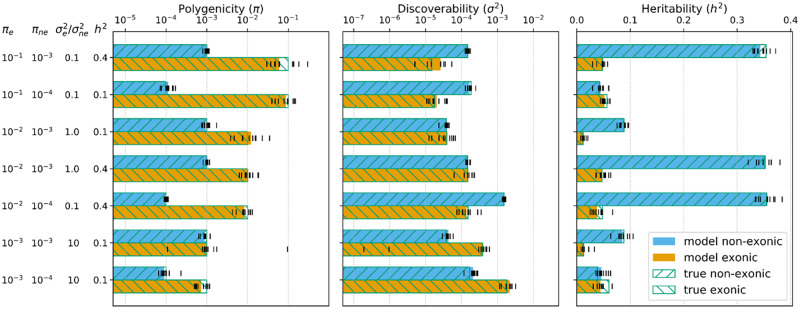
Performance of the model on a selected set of scenarios with synthetic GWAS data. True simulation parameters (πexonic, πnon-exonic, σexonic2/σnon-exonic2 and htotal2) are shown on the left. The blue bars represent the non-exonic category, the orange bars represent the exonic category. The bar lengths represent the median values obtained from 10 optimization runs with independently generated GWAS (locations and effect sizes of non-null variants). The parameter values from individual optimization runs are shown with vertical black dashes. Empty bars with green borders and hatches show the true values of the corresponding parameters used for GWAS simultion